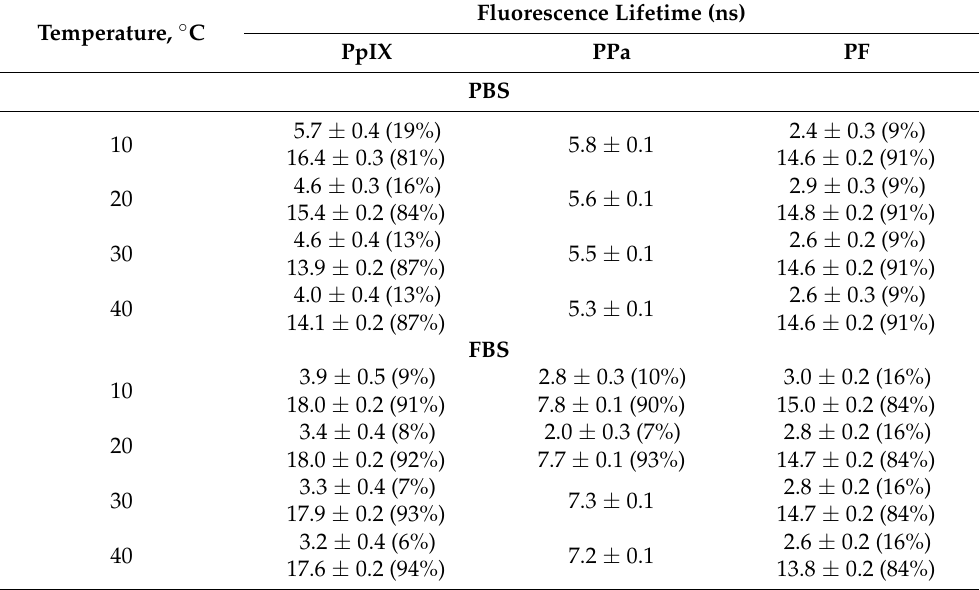
Table 9. Fluorescence lifetimes of PpIX, PPa, and PF ( λ exc = 408 nm, c = 3.1 μ M).